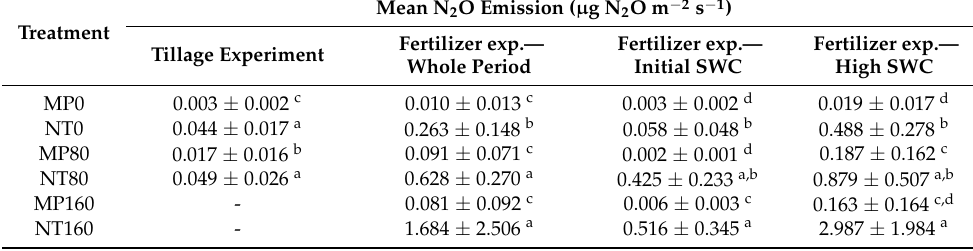
Table 7. Mean N 2 O emission ( ± SD) of laboratory experiments. Small letters indicate significant differences between treatments, within each experiment. Different fertilizer doses: MP 0, 80, 160; NT 0, 80, 160 kg ha − 1 in mouldboard ploughing (MP) and no-tillage (NT), respectively. (Sample numbers are presented in Table